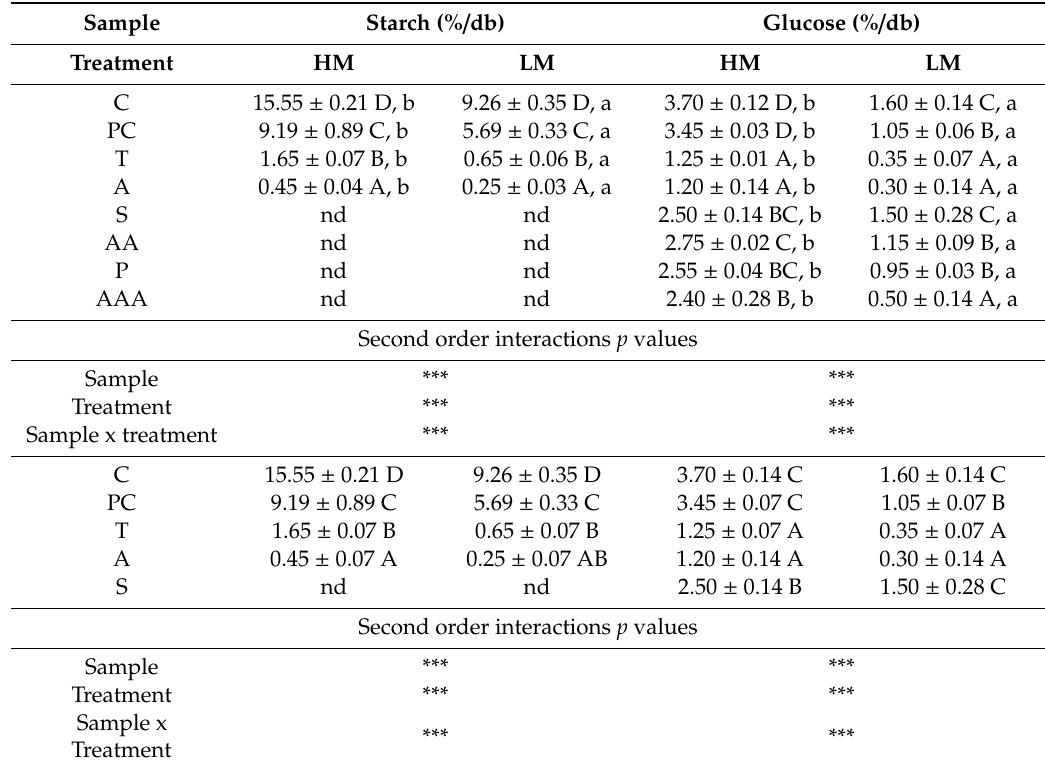
Table 1. Starch and glucose residual content in β -glucan